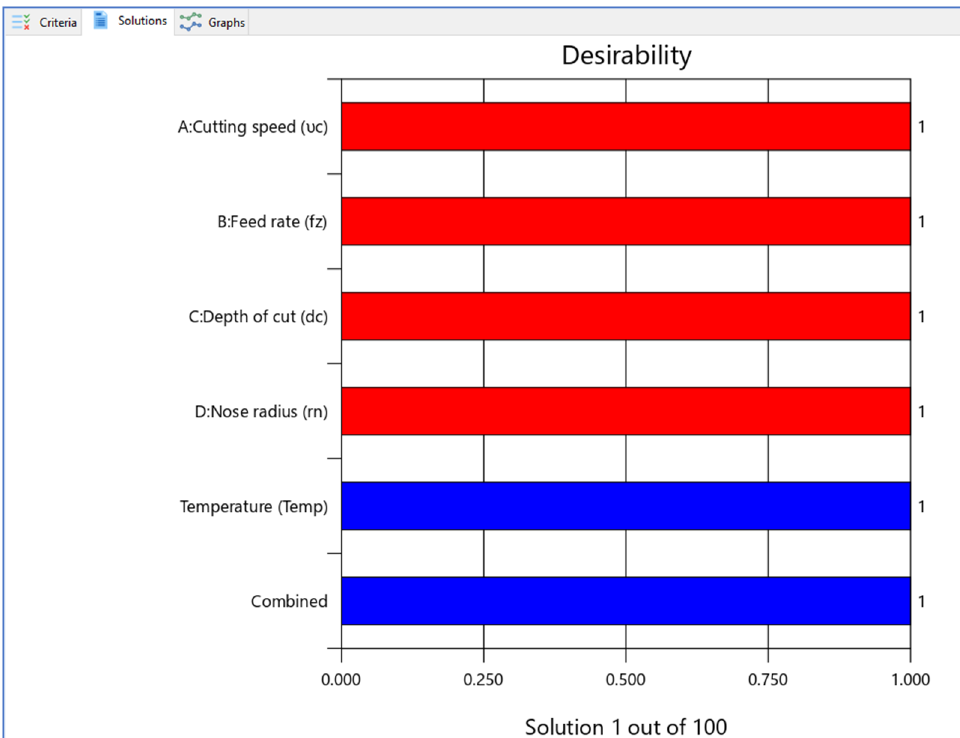
Figure 14. Bar graph of desirability.